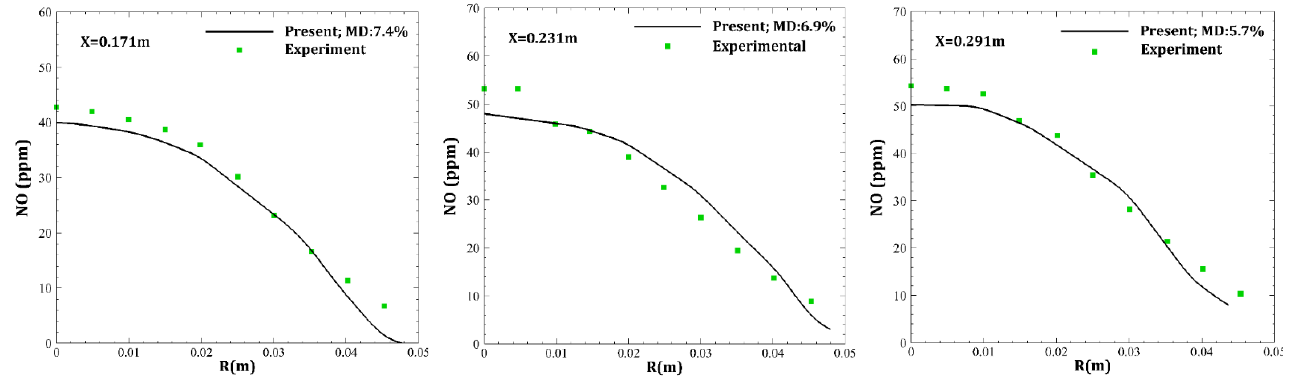
Figure 9. Present lateral profiles of NO species concentration as compared with experimental data [1], at three different positions.